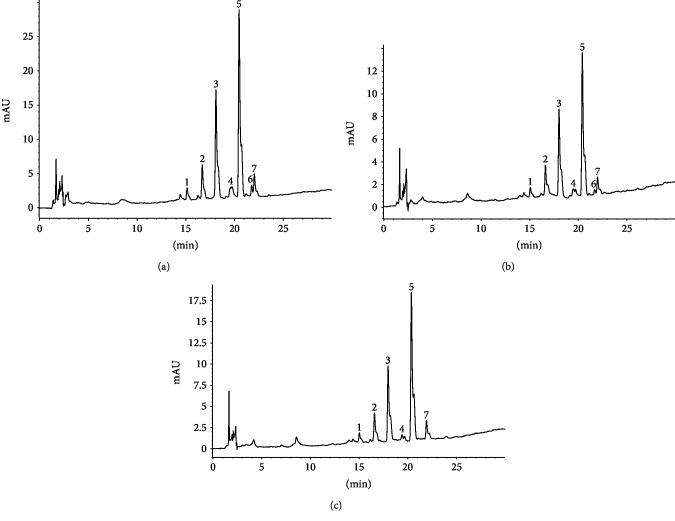
Chromatographic profiles of the hydroethanolic extract (a) 30% (HES30), (b) 50% (HES50), and (c) 70% (HES70) from Kalanchoe brasiliensis fresh leaves collected in September obtained by HPLC-DAD at 254 nm showing the presence of patuletin and eupafolin derivatives. Peak 1: flavonol indicating a methylated or glycosylated patuletin; peak 2: flavonol indicating a methylated or glycosylated patuletin; peak 3: flavonol indicating a methylated or glycosylated patuletin; peak 4: flavonol indicating a methylated or glycosylated patuletin; peak 5: flavonol indicating a methylated or glycosylated patuletin; peak 6: flavone suggesting eupafolin or derivative or flavonol indicating a methylated or glycosylated patuletin; and peak 7: flavone suggesting eupafolin or derivative.